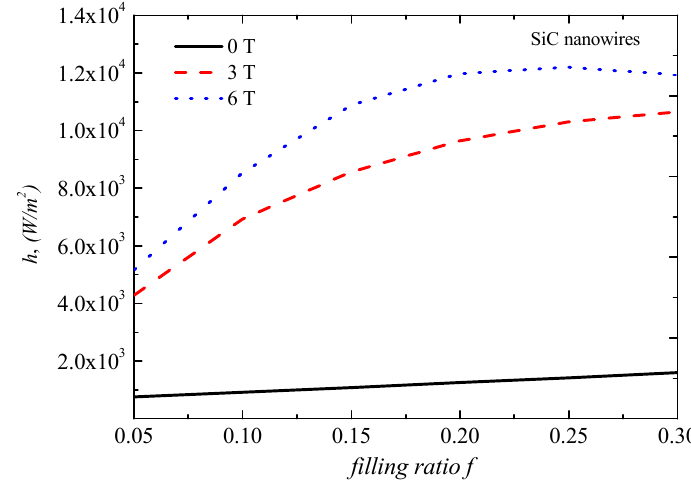
Figure 7. Heat transfer coefficient versus filling ratio of nanowires at a gap distance d = 10 nm.